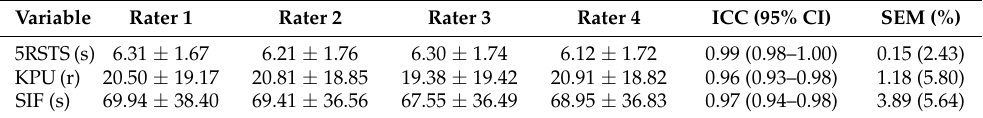
Table 3. Inter-rater reliability ( n =